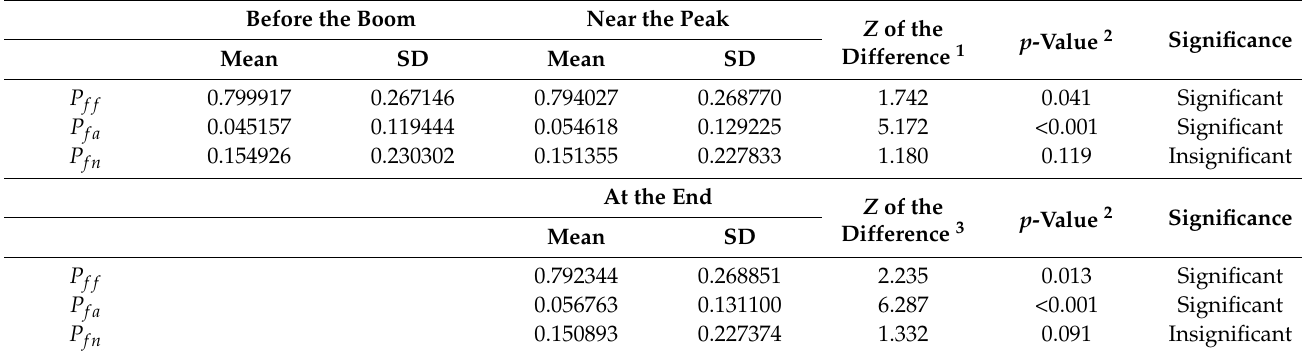
Table 4. The changes in forest fragmentation conditions in Carroll–Harrison counties. Before the Boom Near the Peak Z of the